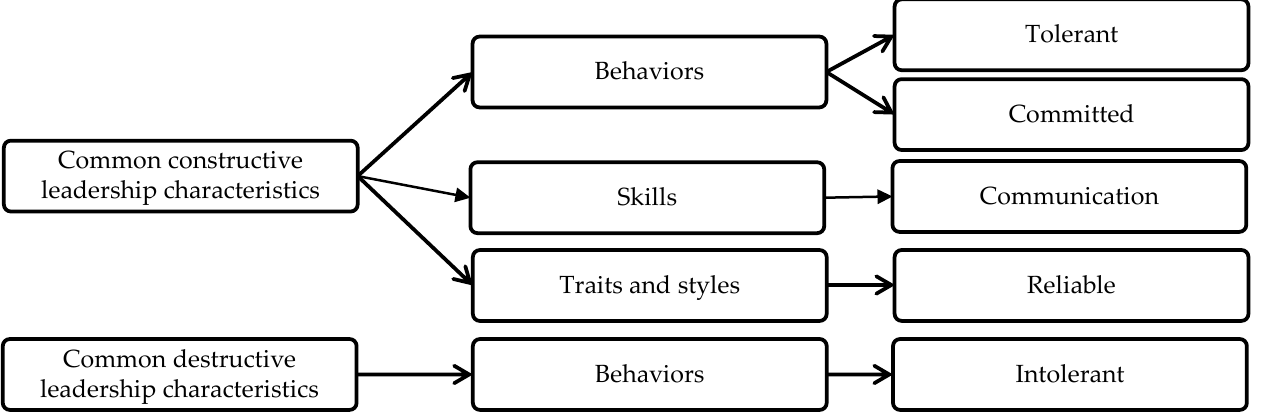
Figure 4. The common constructive and destructive characteristics in BIM-based construction pro- jects.